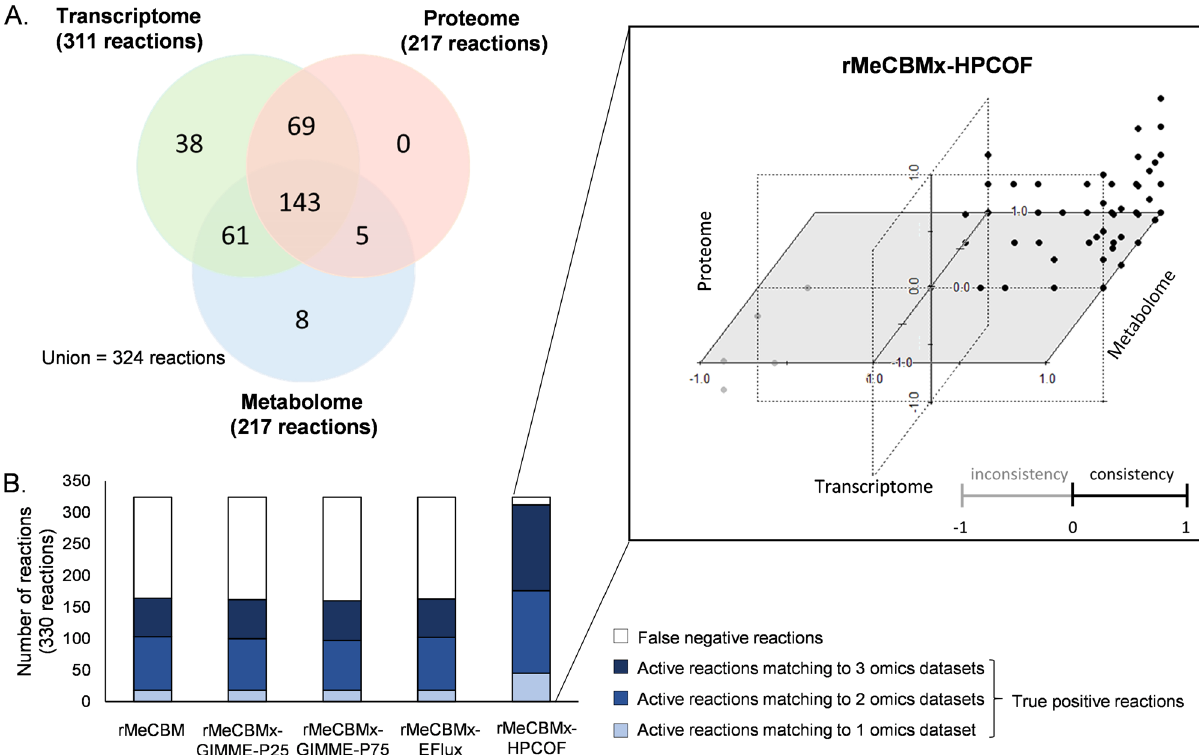
Figure 7. Flux verification by multi-omics data. ( A ) Reactions were indicated to be active based on transcriptome, proteome, and metabolome data. ( B ) Comparison of active reactions from omics data with the flux prediction from each model; rMeCBMx-HPCOF shows the highest consistency of flux prediction with the three omics data, including transcriptome, proteome, and metabolome data, as shown in the graph on the right